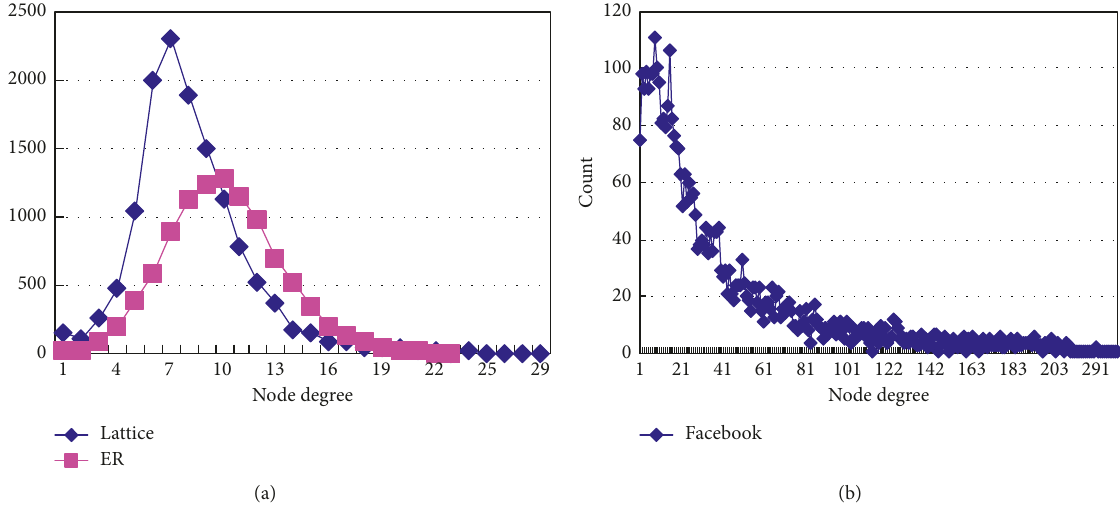
Figure 6: Degree distribution of three kinds of network structures. (a) Lattice and ER. (b)